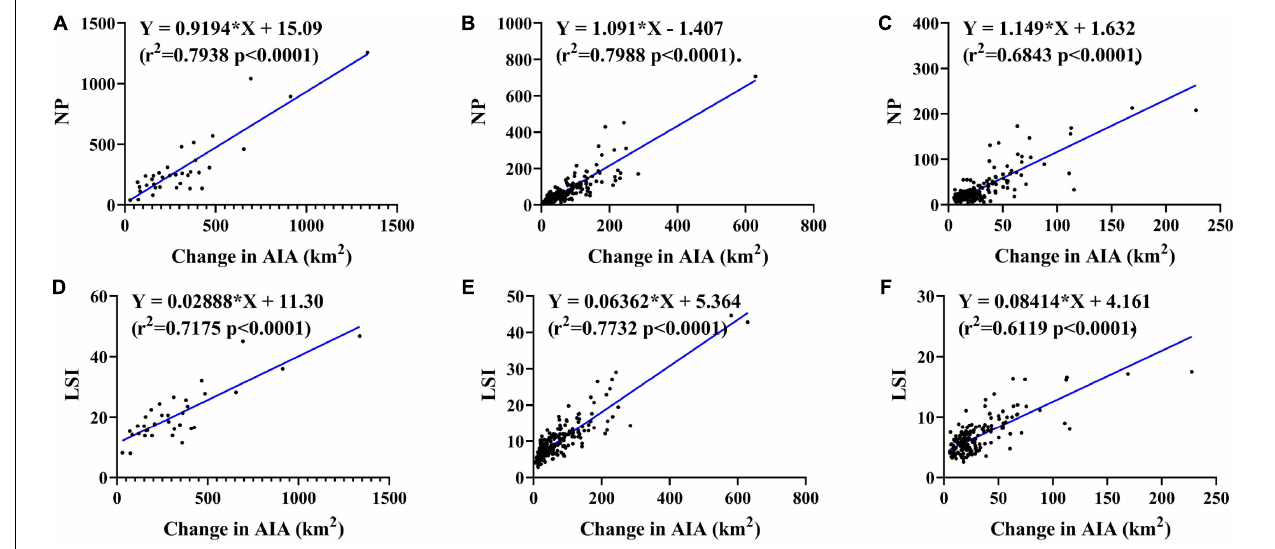
FIGURE 7 | Correlations among the CAIA, landscape metrics, and VG. (A–C) Correlations between the CAIA and NP, and LSI in the provincial-level (A,D) , prefecture-level (B,E) , and county-level cities (C,F)